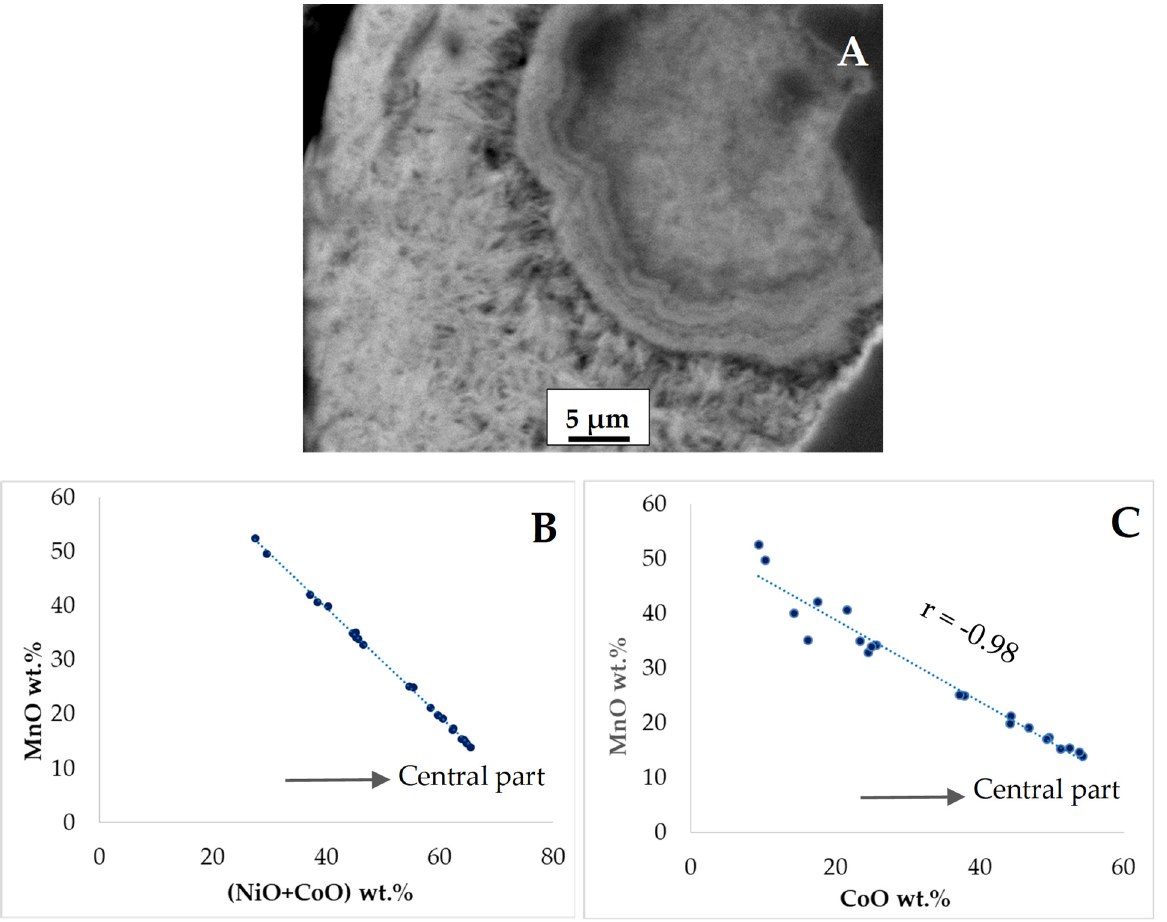
Figure 7. BSE image of (Co-Ni-Mn)-hydroxides showing the concentrating development as succes- sive thin (a few to tens of µ m) layers, composed of fine fibrous crystals ( A ); plots of MnO versus (NiO+CoO) (wt.%) ( B ) and CoO (wt.%) ( C ), exhibiting a wide compositional variation, with increas ‐ ing MnO content outward and maximum CoO content at the central parts ( C ). Data source: present work and Economou ‐ Eliopoulos and Eliopoulos [12].